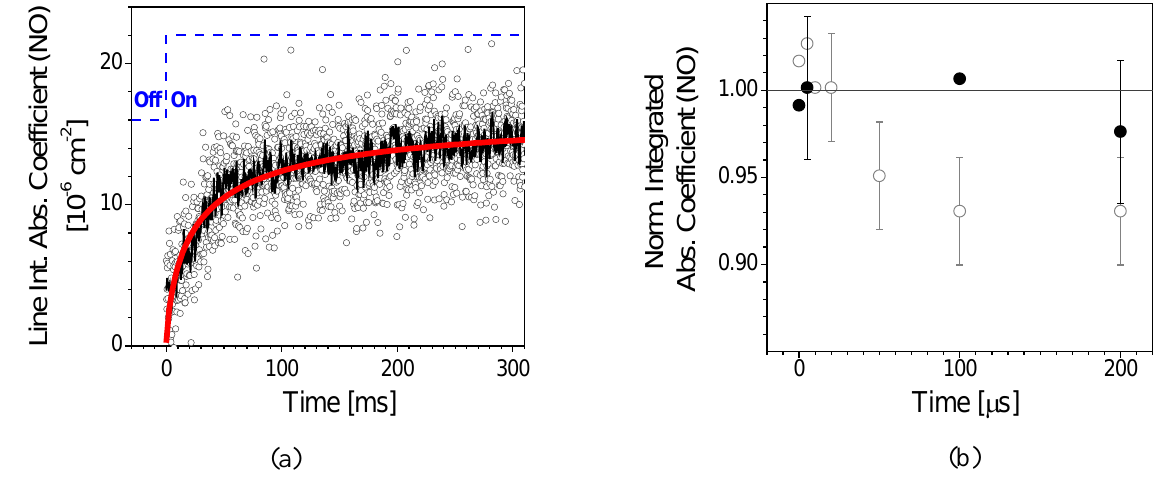
Figure 8. (a) Line integrated absorption coefficient (LIA divided by L ) of NO during the first 300 ms of a pulsed RF plasma. Measurements were performed every 0.2 ms (open circles). Binning of 6 spectra (thin solid line) yields a better SNR and an effective 1 ms time resolution. The trend (heavy solid line) serves as a guide to the eye. (b) Normalized LIA of NO measured during the first 200 µs of a pulsed 1 ms DC discharge. The uncertainty of single shot results (full black circles) could be reduced by averaging over 5 plasma cycles (open grey circles) at the expense of a drastically increased measurement and post-processing time (enlarged from